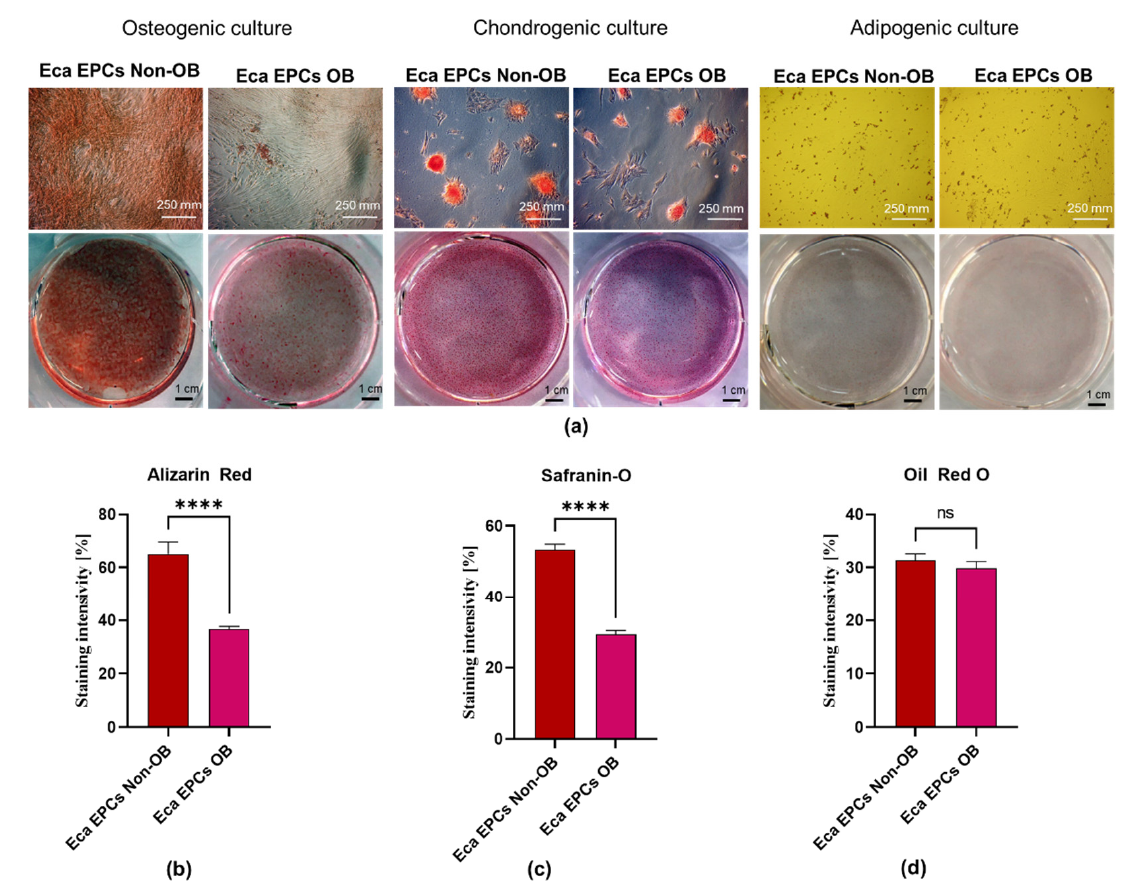
Figure 2. The analysis of Eca EPCs multipotency. Tissue-specific differentiation extracellular matrix features were documented ( a ). Cultures were maintained under osteogenic, chondrogenic and adipogenic conditions. Calcium deposits formed under osteogenic conditions were detected using Alizarin Red staining, while chondrogenic nodules were stained with Safranin-O dye. The lipid-rich vacuoles after adipogenic stimulation were detected with Oil Red O. The staining efficiency was measured to compare the differentiation potential of Eca EPCs non-OB with Eca EPCs OB ( b – d ). Columns with bars represent means ± SD. **** p -value < 0.0001, while ns symbol refers to non-significant differences.